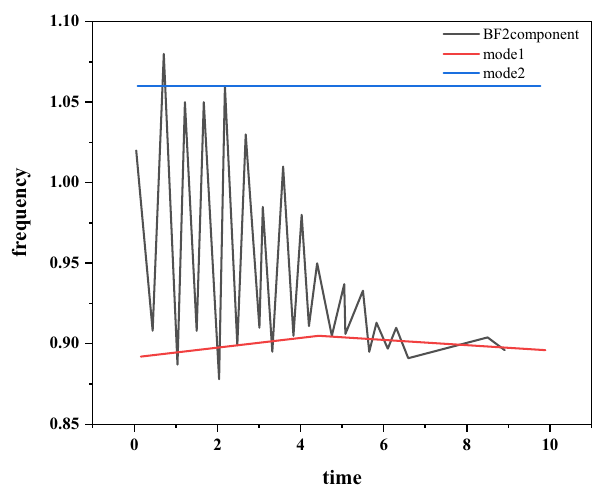
Figure 7: Component without damping frequency and contrast